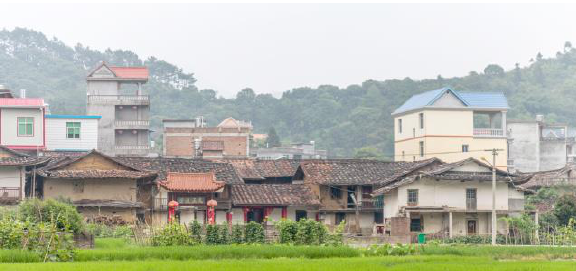
Figure 10. One of the fifteen ancestral halls. Photo by the first author (2018).